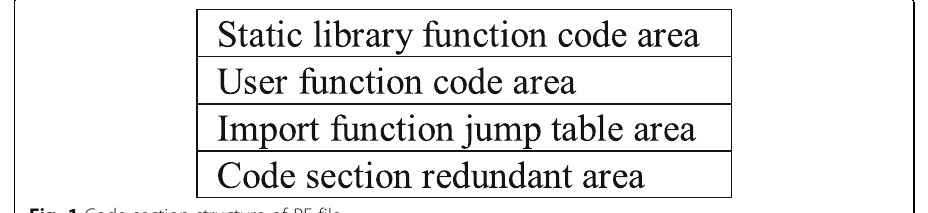
Fig. 1 Code section structure of PE